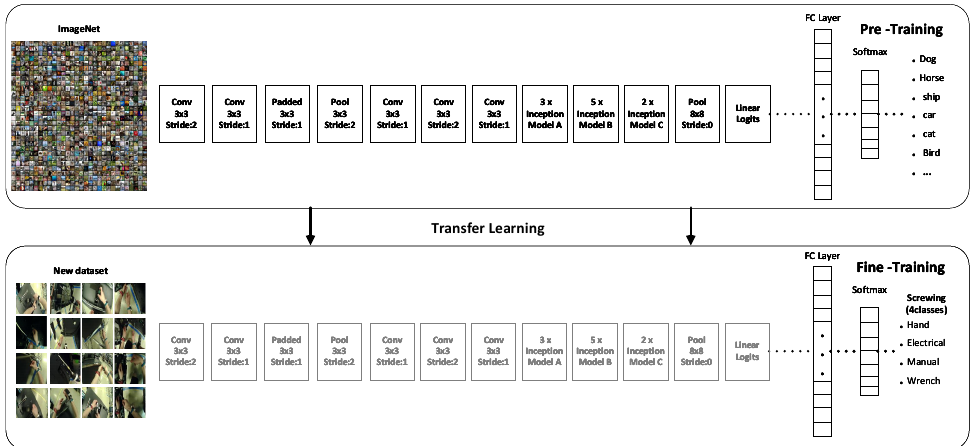
Figure 5. Transfer learning architecture. A convolution network is fine-tuned by getting the weights from another convolution network (pre-trained Inception-V3).